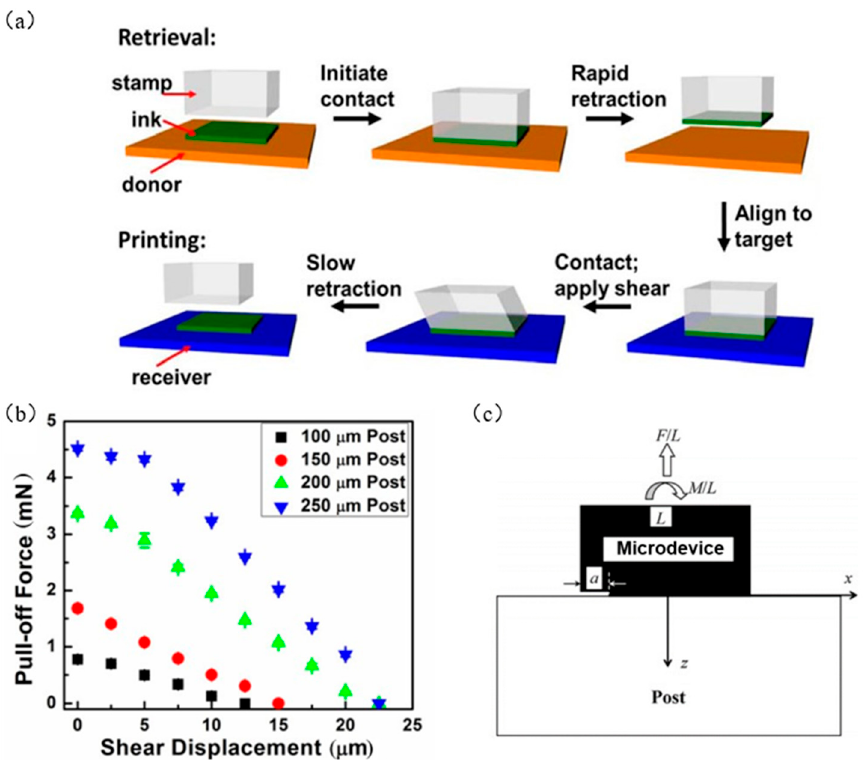
Figure 11. Transfer printing technology with an applied shear load. ( a ) Diagram of transfer with applied shear load (reproduced from [73]), ( b ) the relationship between shear displacement and adhesion (reproduced from [73]), and ( c ) transfer fracture mechanics model with shear load (reproduced from [84]).